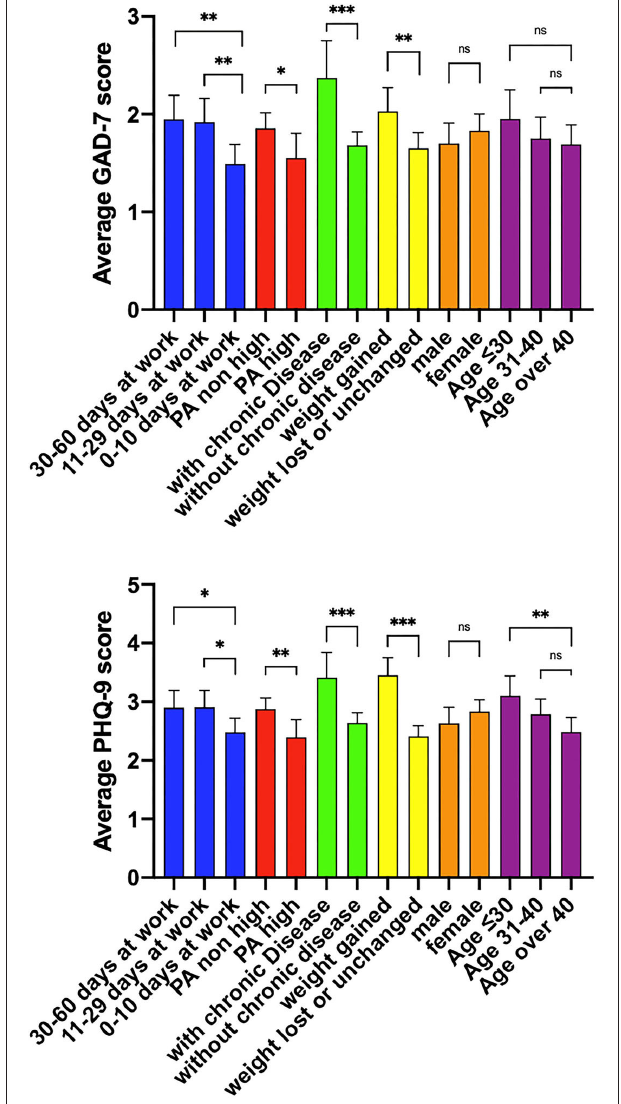
FIGURE 1 | Average GAD-7/PHQ-9 scores in different characteristic groups of participants. PA high: participants who had high level of physical activity. PA non-high: participants who had medium or low level of physical activity. According to the IPAQ scoring guide listed previously, Physical activity status of the participants were graded high, medium and low. In this article, medium and low levels of physical activity were combined as PA non-high. The other characteristic groups were described in Table 1 . * p < 0.05, ** p < 0.01, *** p < 0.001, ns, not